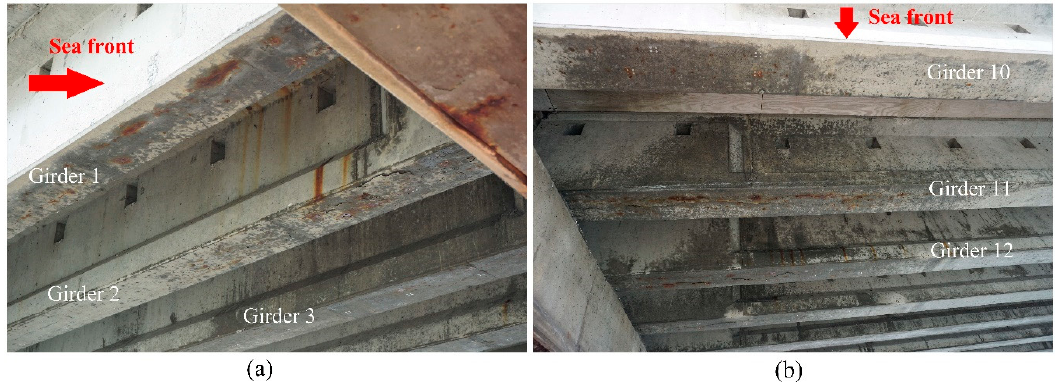
Figure 4. Corrosion-induced damage and humid areas in NIB girders: ( a ) in the first bridge span (1st to 3rd girders facing the sea) next to the middle support; ( b ) in the second bridge span (1st to 3rd girders facing the sea) next to the middle support.